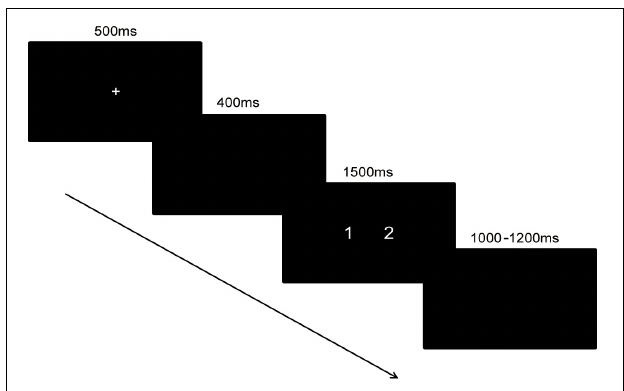
FIGURE 1 | The time course of magnitude comparison